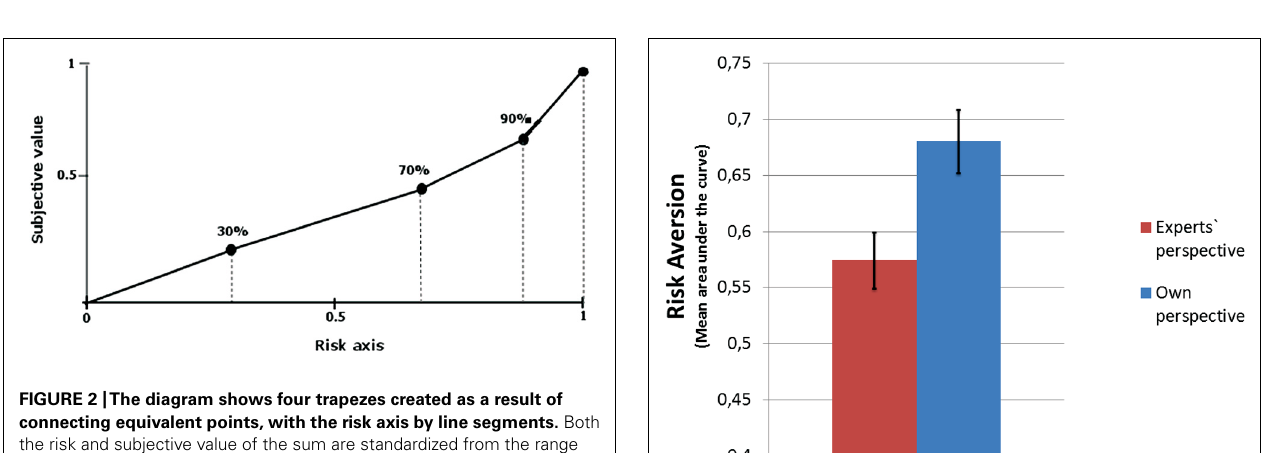
FIGURE 1 | Mean certain equivalents for own/expert perspective compared to expected value model.